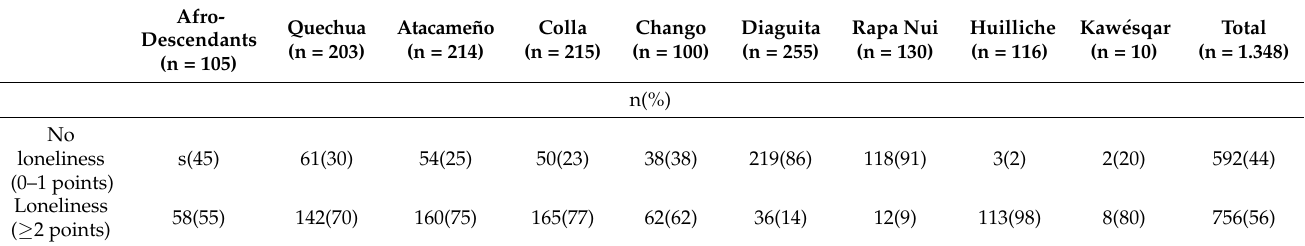
Table 2. Prevalence of loneliness through DJGLS-6, by ethnic